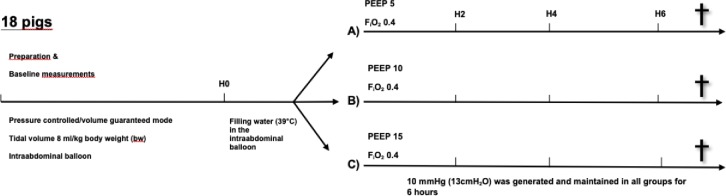
Experimental model study protocol.After instrumentation and a 30-min stabilization period animals underwent measurements at H0 with PEEP 5 and no elevated intraabdominal pressure (IAP). Thereafter the intraabdominal balloon was filled with water up to an IAP of 10 mmHg. Animals were randomized afterwards to the three different groups with group A: PEEP 5 cmH2O, group B: PEEP 10 cmH2O and group C: PEEP 15 cmH2O. The IAP was held at 10 mmHg for 6 hours.